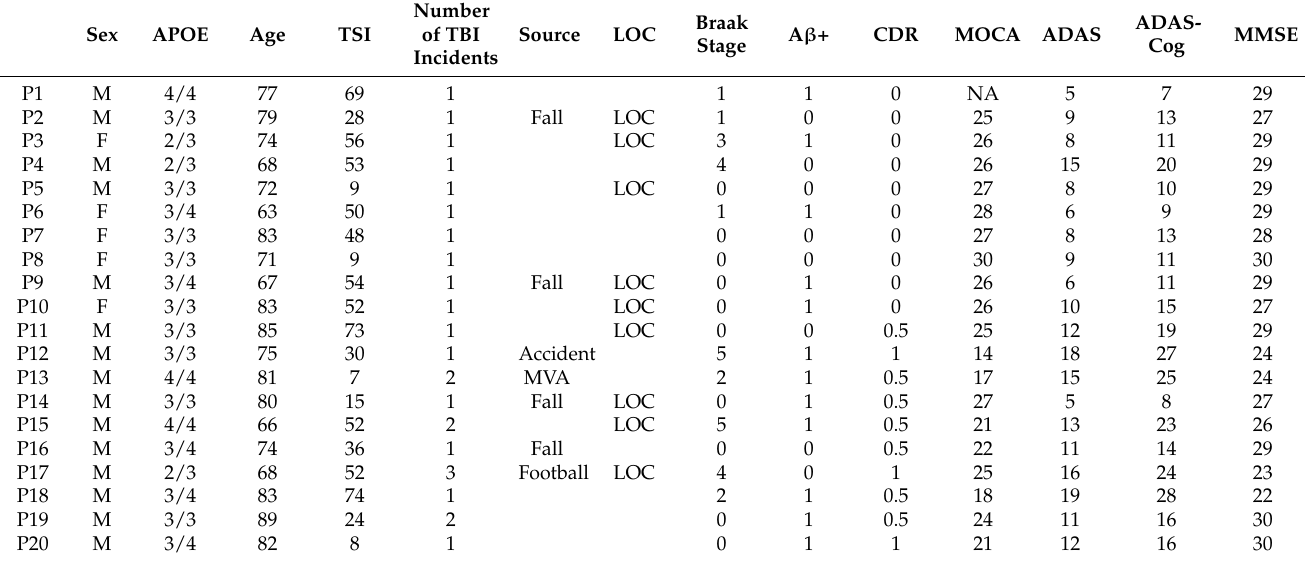
Table 1. Clinical characteristics of participants with self-reported history of